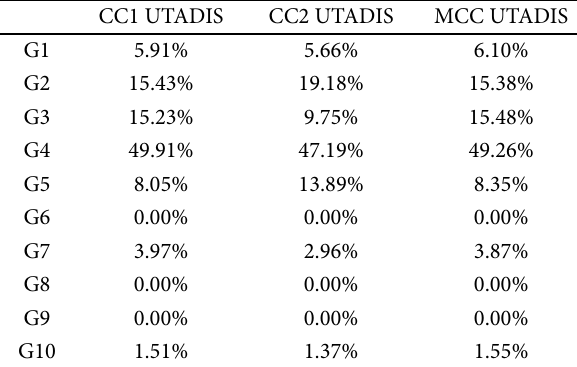
table 6. criteria weights for evaluation criteria